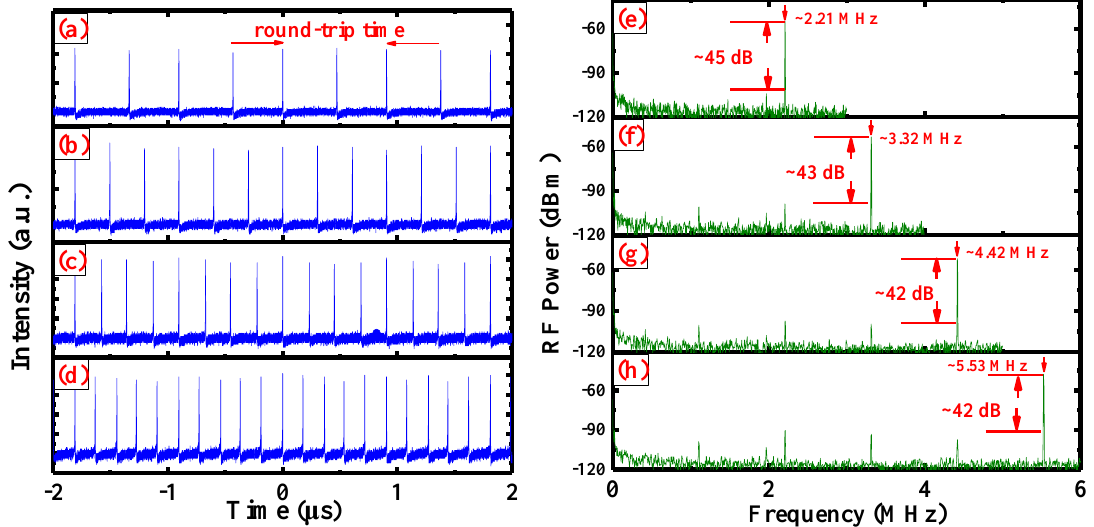
Figure 6. Pulse trains for ( a ) 2nd HML, ( b ) 3rd HML, ( c ) 4th HML and ( d ) 5th HML as well as the corresponding RF-spectra for ( e ) 2nd HML, ( f ) 3rd HML, ( g ) 4th HML and ( h ) 5th HML,